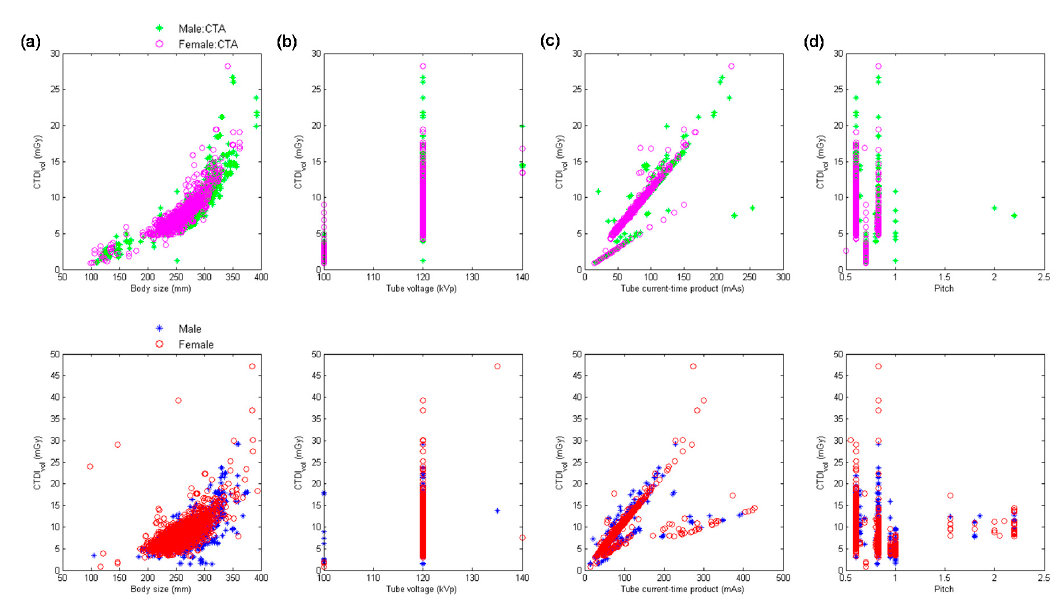
Figure 6. Scatter plots of CTDI vol versus ( a ) body size, ( b ) kVp, ( c ) mAs, and ( d ) pitch for abdominal CTA scans ( upper row) and abdominal scans excluding CTA ( lower row) performed using MDCT H . Table 9. Results of multivariate analysis for the abdominal scans performed using MDCT H .